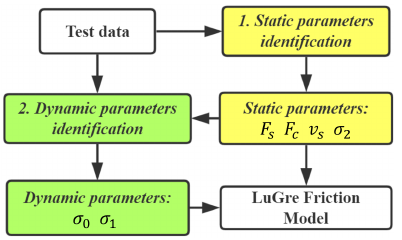
Figure 6. GA program of LuGre model parameters identification. Table 2. Lugre friction model parameters.